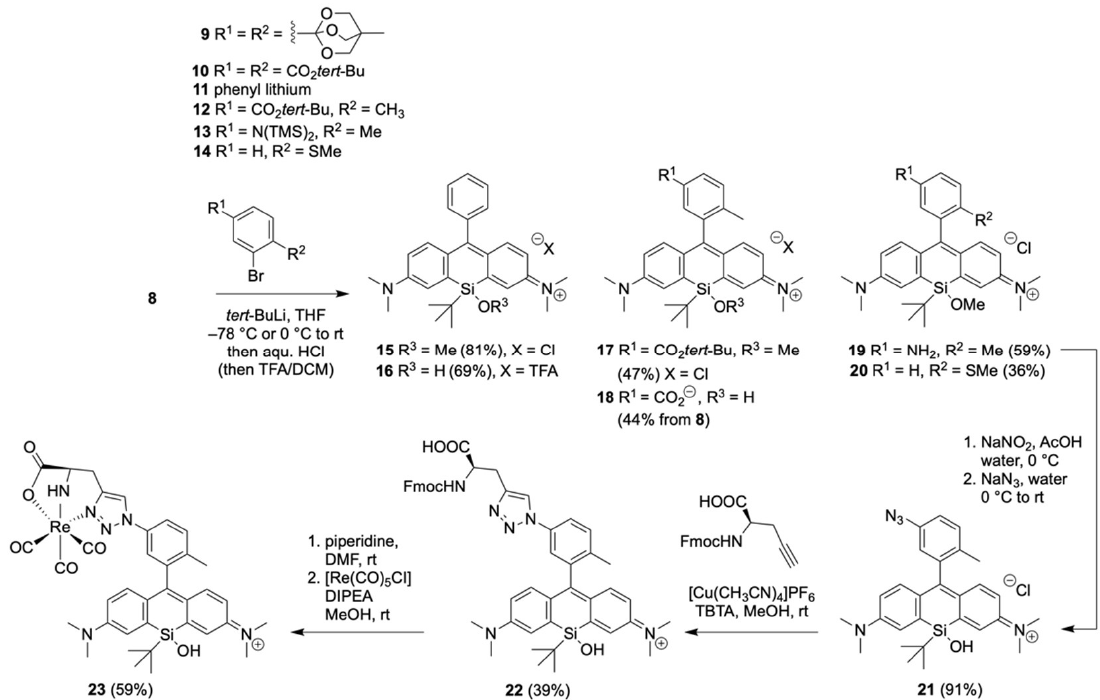
Figure 4. Synthesis of SiRs containing a ( tert -butyl)MeOSi-motif. Amine 19 can be converted to azide 21 via diazotization. Copper-catalyzed click chemistry leads to triazole 22 , which can complex